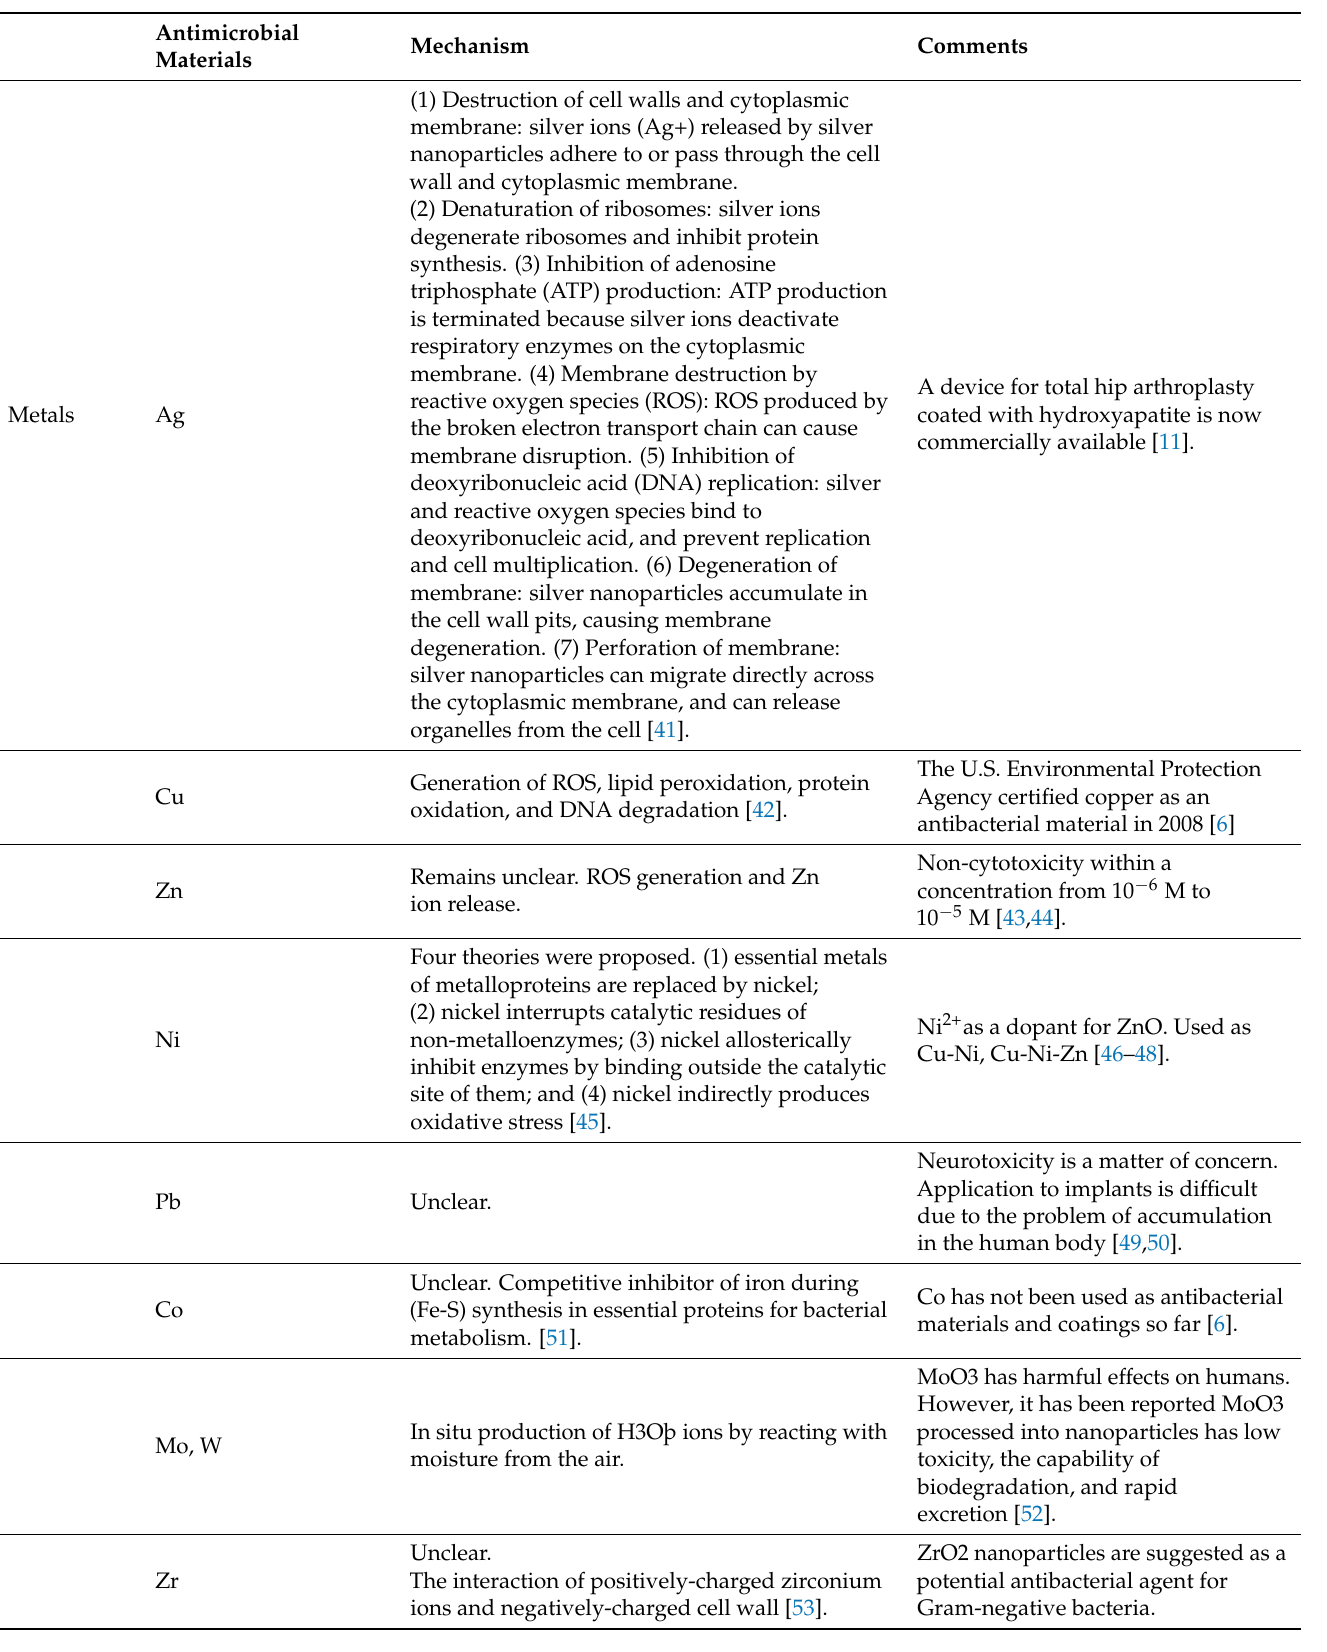
Table 1. Antimicrobial